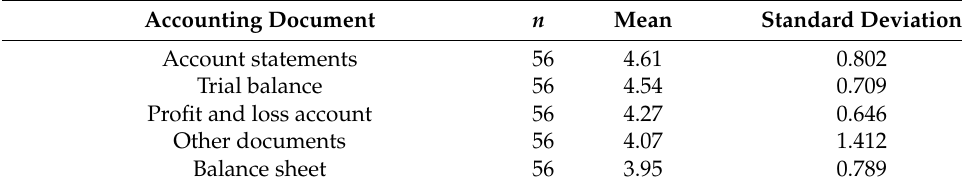
Table 4. Frequency of use of accounting